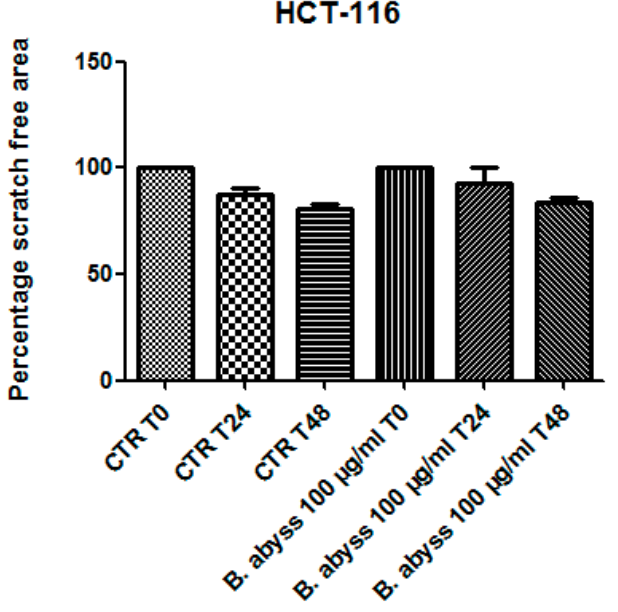
Figure 4. E ff ects of B. abyssinica water extract 100 µ g / mL on the spontaneous migration of colon cancer HCT116 cells (wound healing test). The spontaneous migrations were assessed at 0, 24, and 48 h following experimental lesion of the cell monolayer. Data are means ± SD and analyzed through analysis of variance (ANOVA), followed by post hoc Newman–Keuls test. The statistical analysis showed a null e ff ect exerted by the extract on HCT116 cell